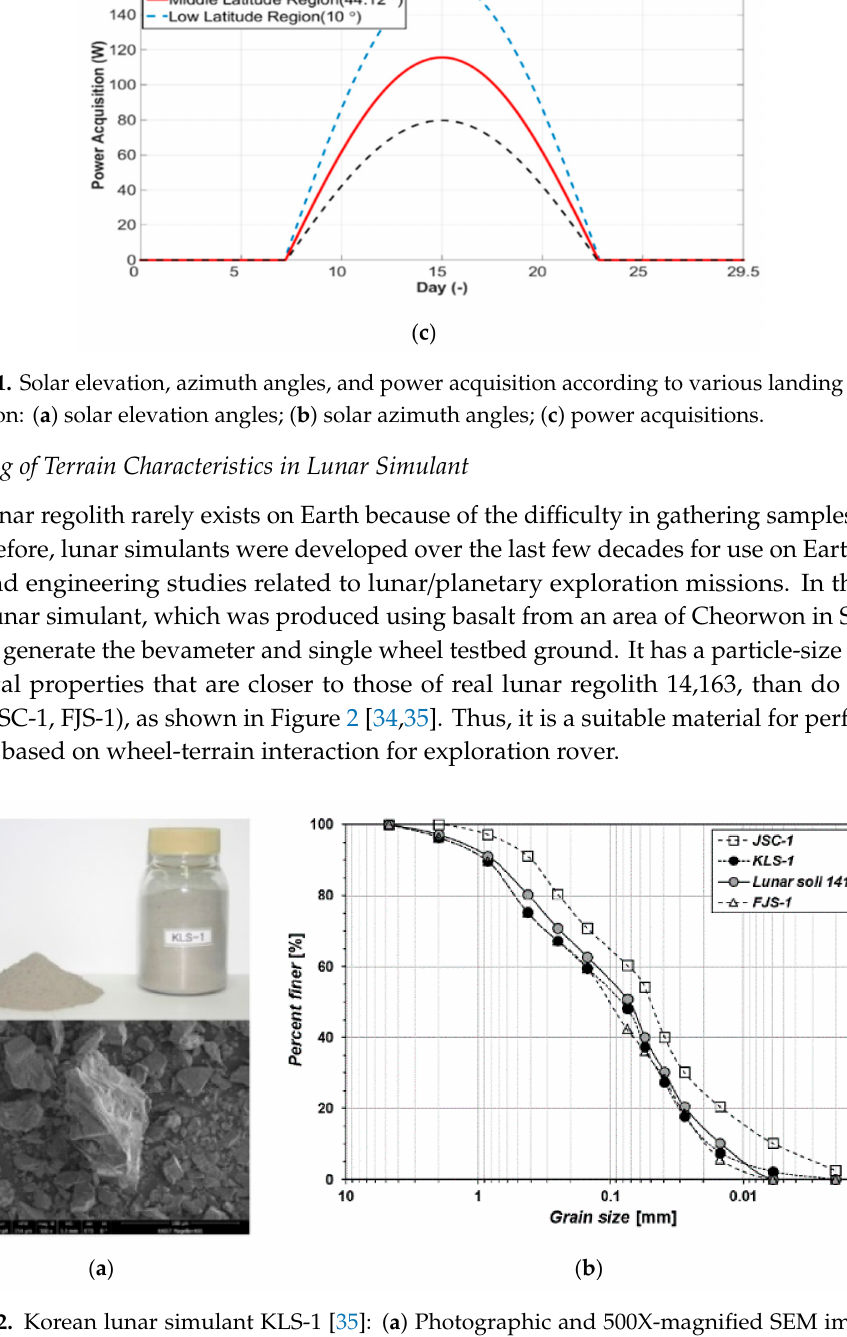
Figure 2. Korean lunar simulant KLS-1 [35]: ( a ) Photographic and 500X-magnified SEM images of KLS-1 lunar simulant; ( b ) particle-size distribution of real lunar regolith 14,163 and lunar simulants JSC-1, FJS-1, and